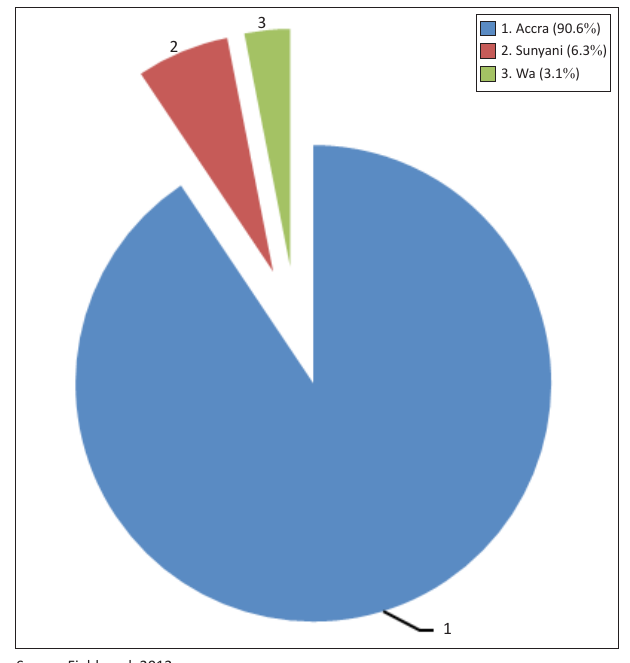
FIGURE 2: Distribution of transport